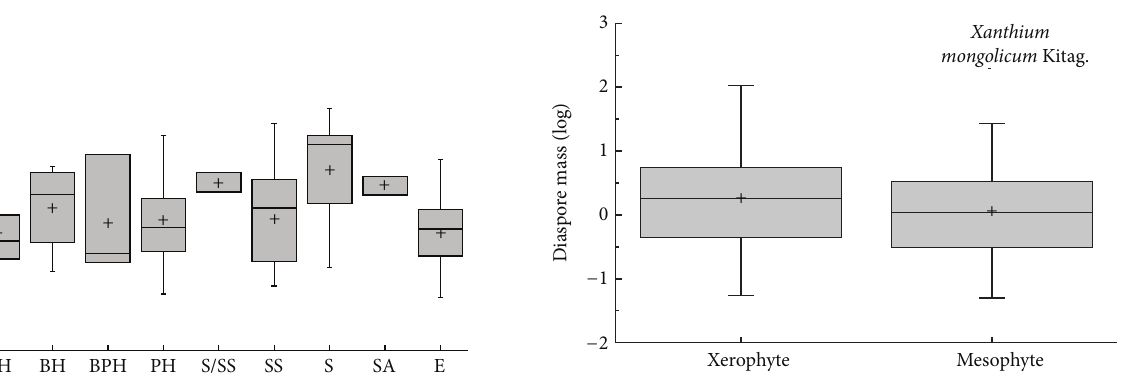
Figure 2: Box plots showing mean (+), median (—), quartiles, and outliers (-) of diaspore mass of 150 species grouped by different vegetative periods. Because annual-biennial (ABH) species is only one species, it does not compare with others. AH = annuals; ABH = annuals/biennials; BH = biennials; BPH = biennials/perennials; PH = perennials; S = shrubs; SS = semishrubs; SA = small arbor; AE = annuals ephemerals; ABE = annuals/biennials ephemerals; BE = biennial ephemerals.